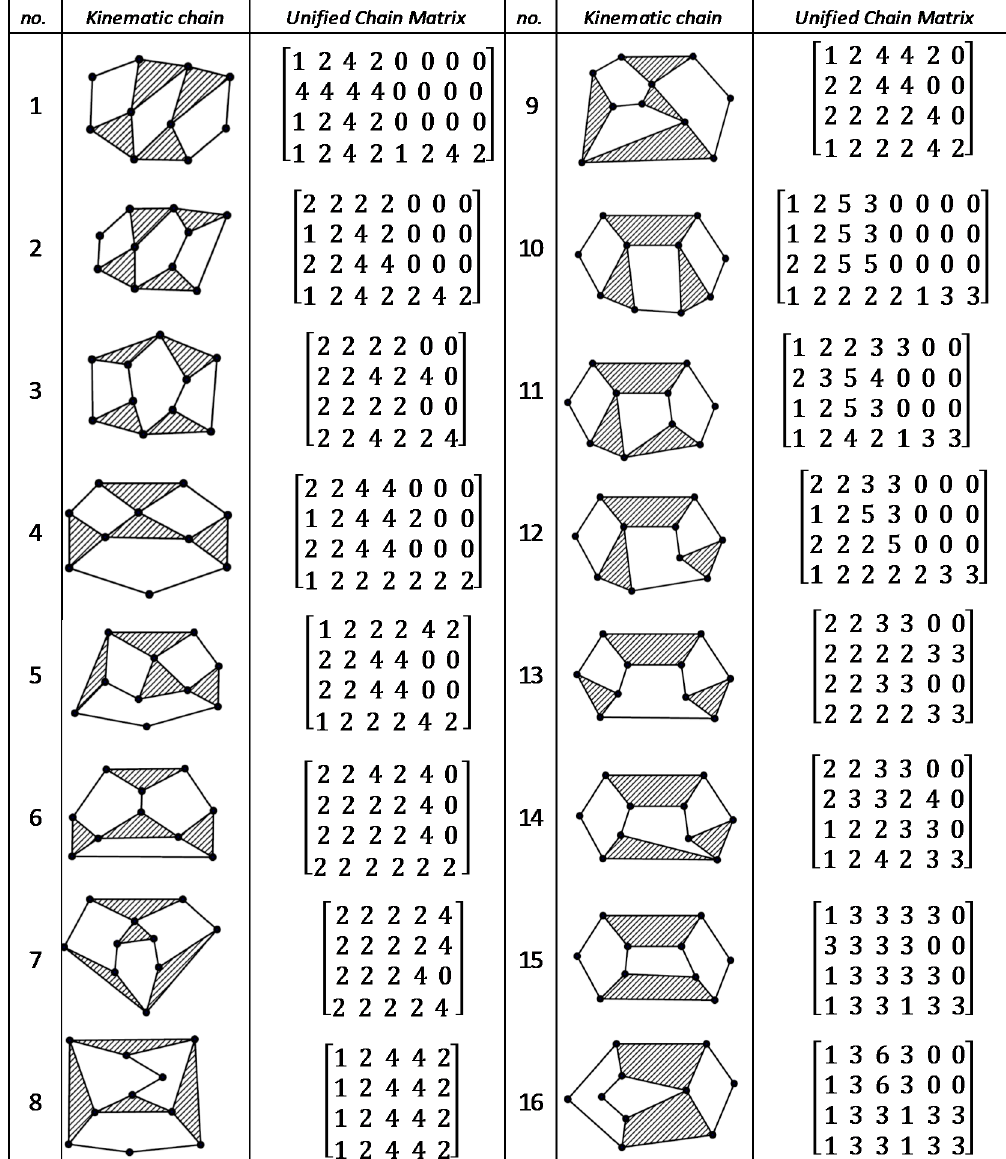
Figure A7. Unified chain matrix, UCM, for all 8 links 1-DOF KCs with simple joints [37].